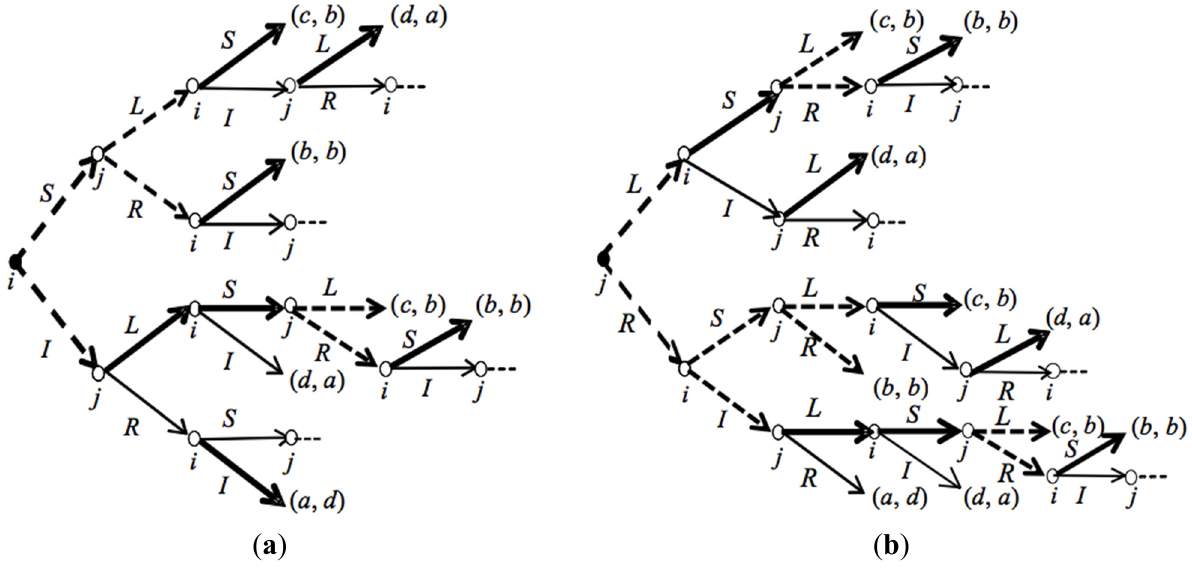
Figure 8. CP ( G ), G being the original game in Figure 7, with i ( a ) or j ( b ) as first